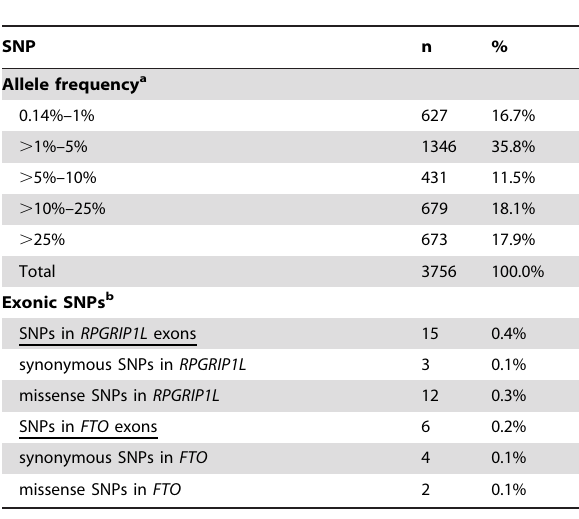
Table 2. Distribution of allele frequency of SNPs in the FTO fine-mapping